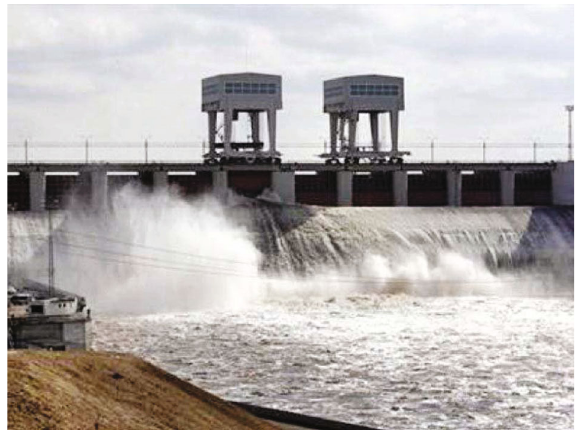
Figure 4: Source of hydropower